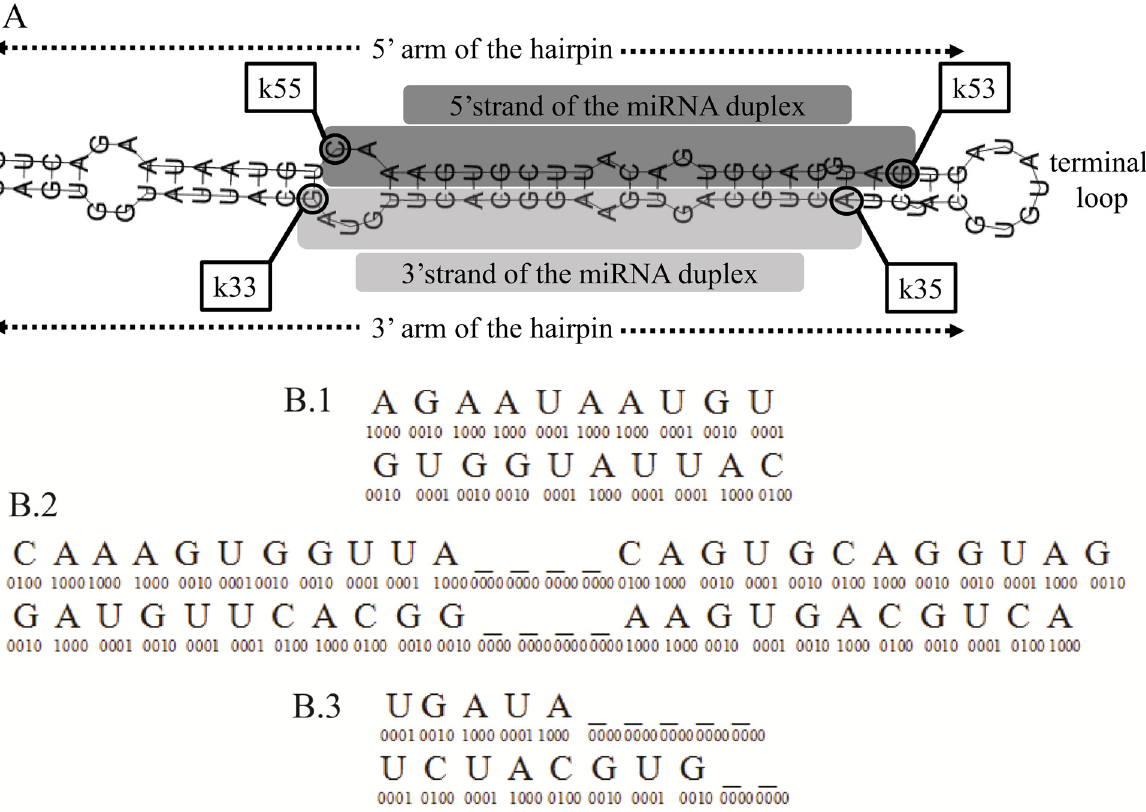
Fig 1. hsa-mir-17 example. A. Anatomy of the hsa-mir-17 hairpin, showing the duplex (grey)and its four ends (k55, k53, k33, k35). B. Vector representation of the true miRNA duplex of the hsa-mir-17 with 10 nucleotides flanking region. B.1. Flanking region of 5 0 strand 5 0 end (top), and 3 0 strand 3 0 end (bottom), no zero padding needed. B.2. Duplex sequence, 5 0 strand (top), 3 0 strand (bottom). Zero padding occurs in the middle to reach the maximum (27nts top, 26nts bottom) length observed in the training set. B.3 Flanking region of 5 0 strand 3 0 end (top), and 3 0 strand 5 0 end. Zero padding is performed at the end as flanking region extends beyond the loop tip. Adopted from [15] with